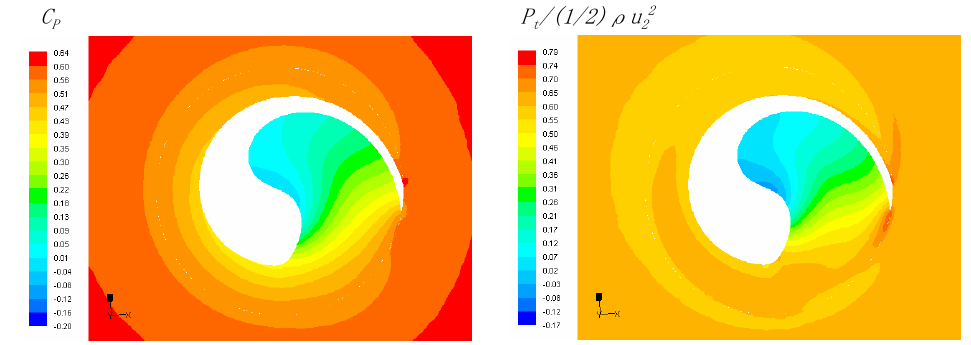
Fig. 12 Impeller blade loading distributions ( φ =0.025)